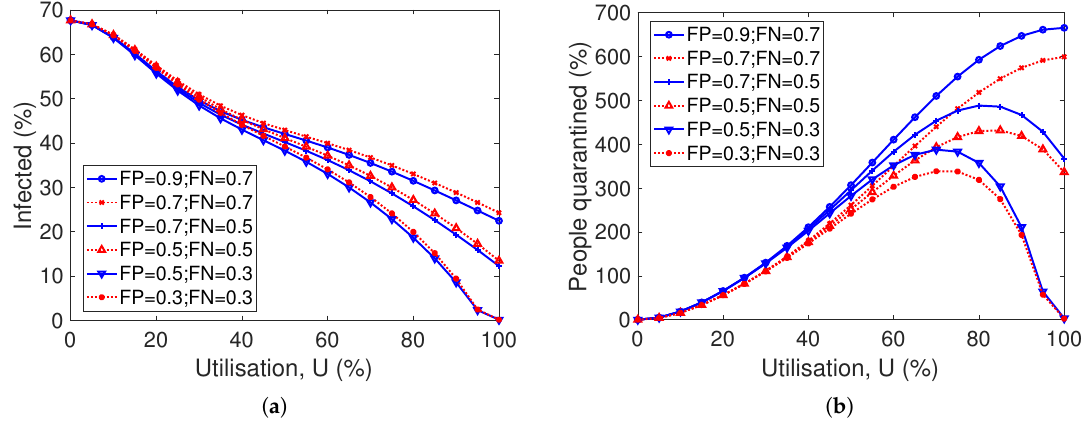
Figure 5. Impact of accuracy. That is, the impacts of false positive and false negative ratios on the efficiency of contact tracing. All plots are for R 0 = 3, 1/ τ T = 1 day and RC = 0.6: ( a ) percentage of population infected; ( b ) percentage of population